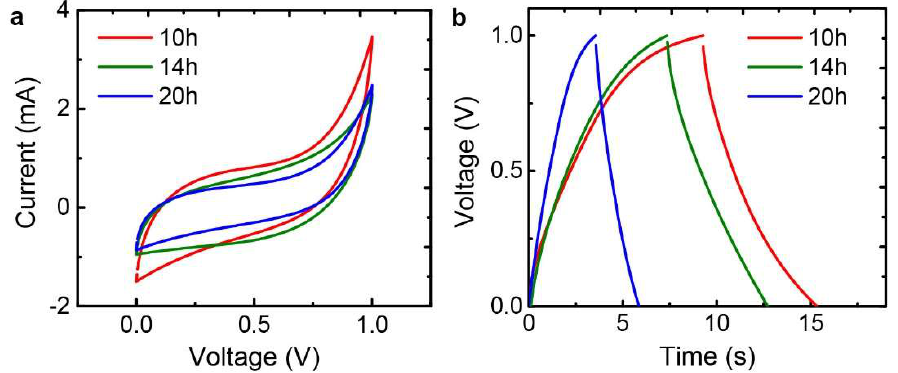
Figure 9. Electrochemical performance of the fabricated rGO papers as electrode materials in supercapacitor cells with 6 M KOH electrolyte depending on different sonication times. ( a ) CV curves at a voltage ramp rate of 100 mV/s. ( b ) Galvanostatic charge/discharge curves at a current density of 2 A/g.